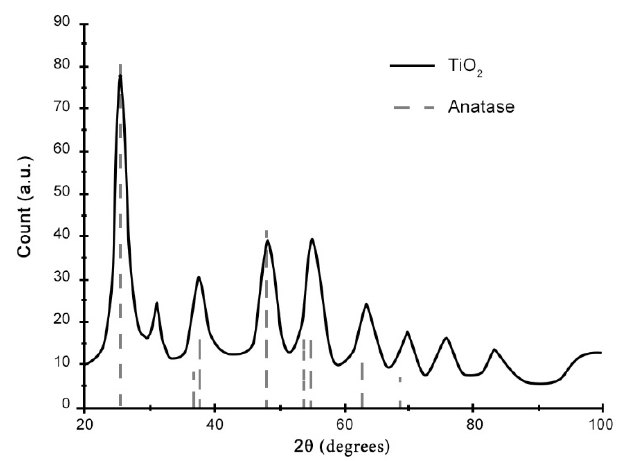
Figure 1. XRD pattern of TiO 2 solution.